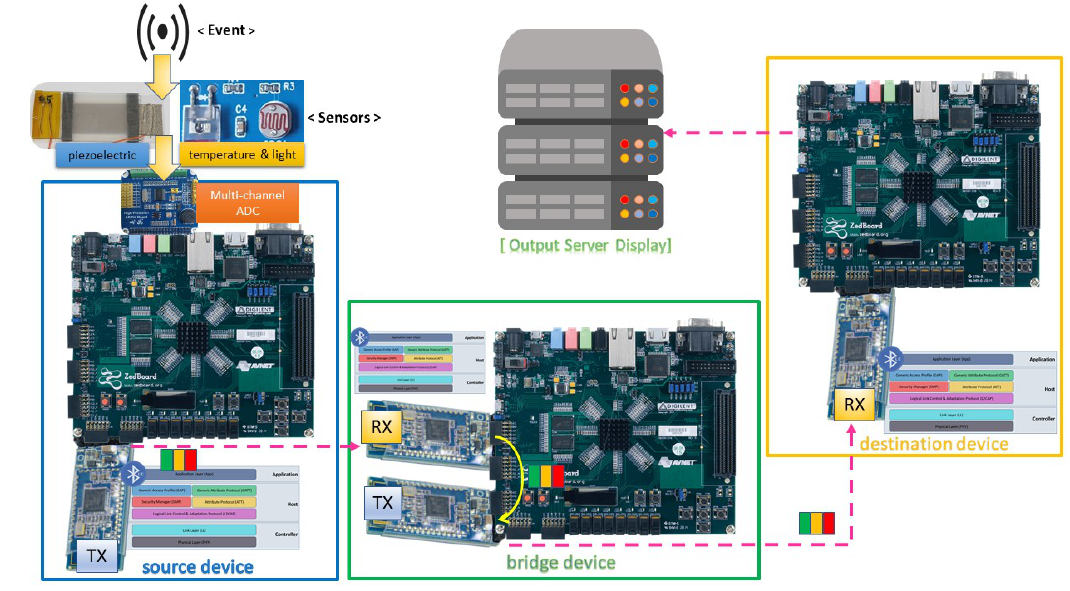
Figure 7. Network structure and